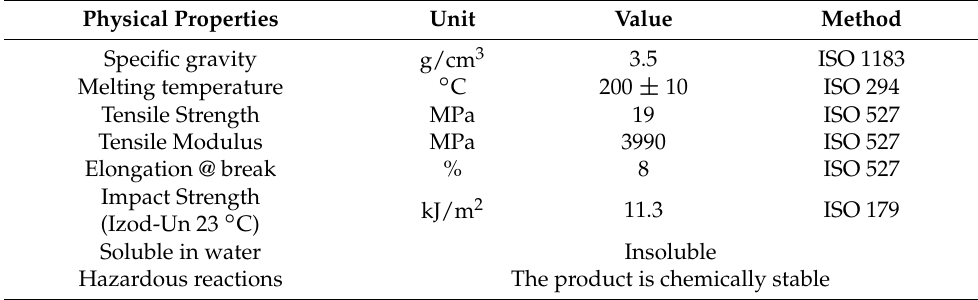
Table 1. Typical Material Properties of MetalFil-Ancient bronze, PLA-based filament.